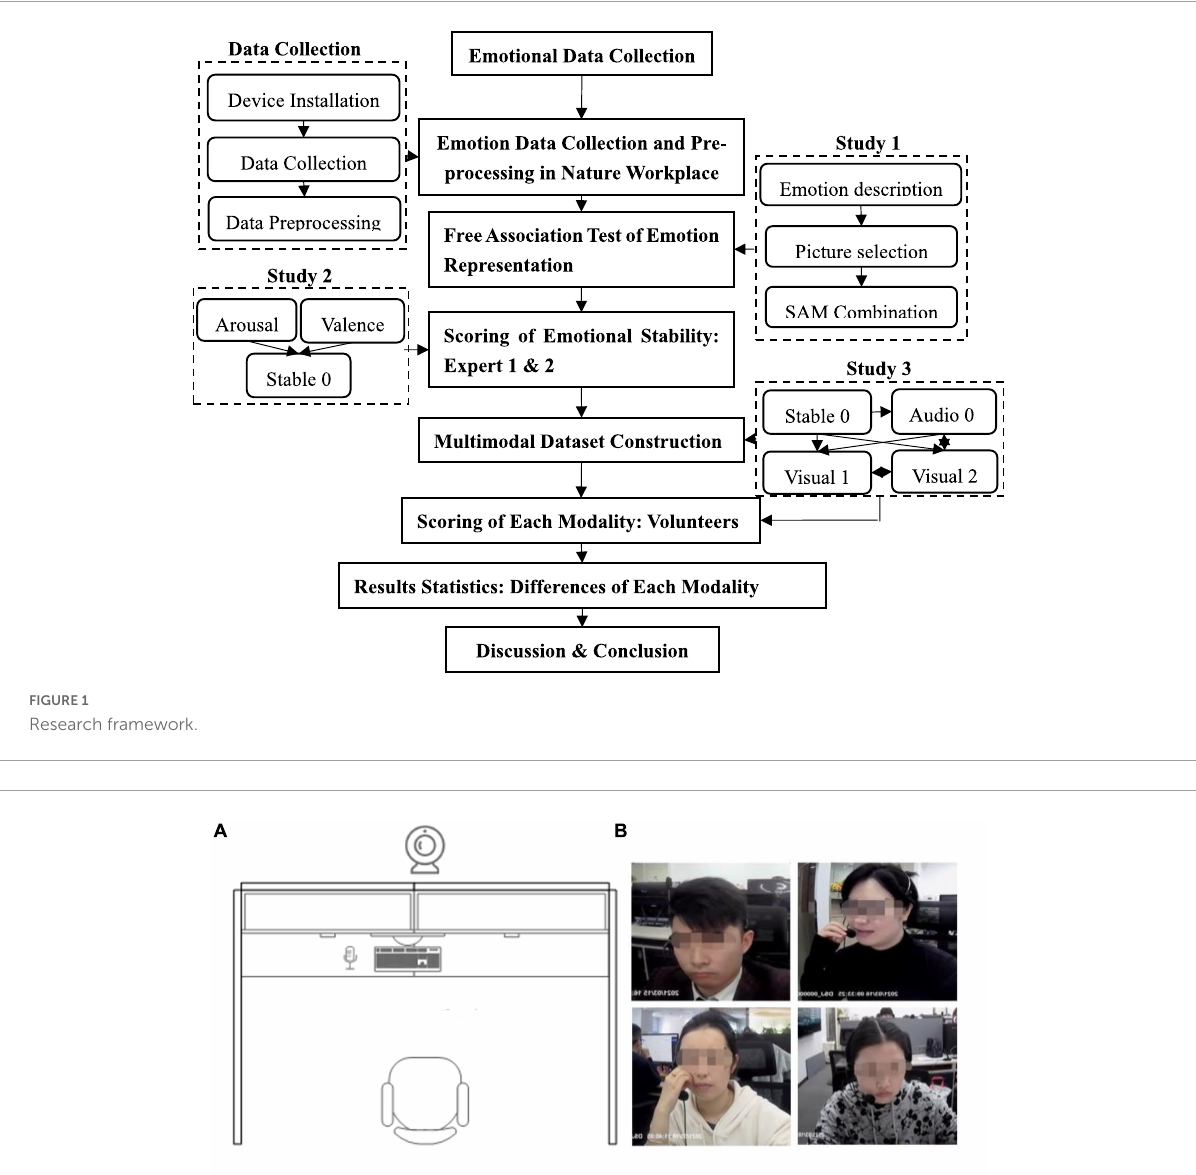
FIGURE2 Data acquisition schematic. (A) Data collection diagram. (B) Results presentation